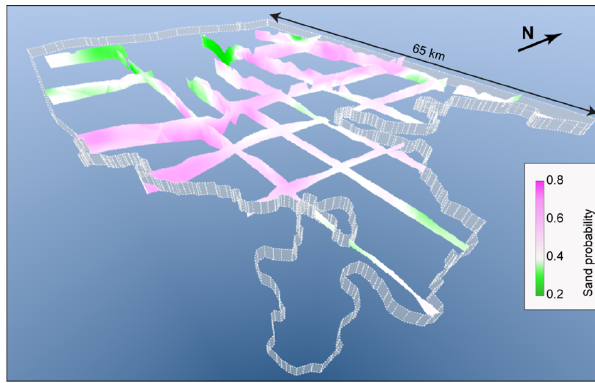
Figure 9. Three-dimensional fence view into the sand probability grid, seen from south-east. Vertical exaggeration = 10 ×